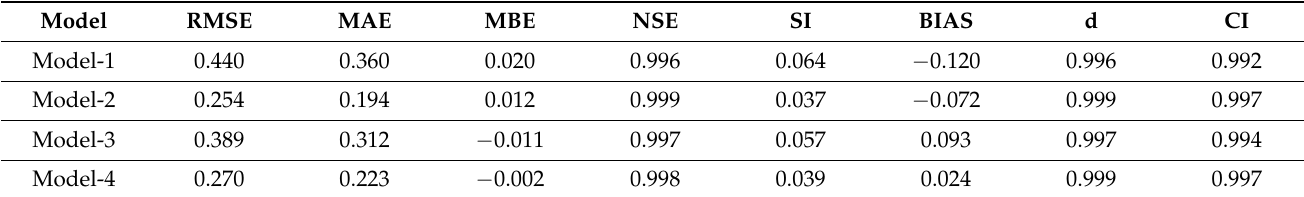
Table 4. Statistical indicators values using MLPNN method during testing